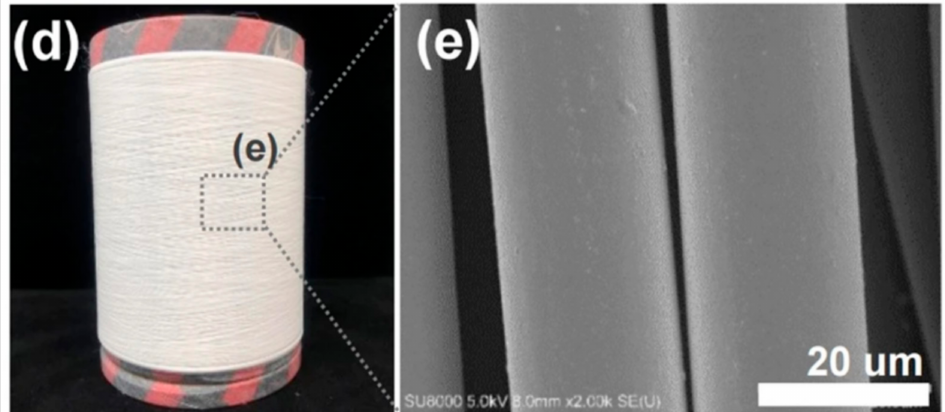
Figure 2. ( d ) Obtained as-spun PLLA fiber reinforced with BaTiO 3 particles by the pilot-scale melt- spinning, and ( e ) FE-SEM image of the as-spun PLLA/BaTiO 3 fibers. Reprinted with permission from Nature Publishing Group